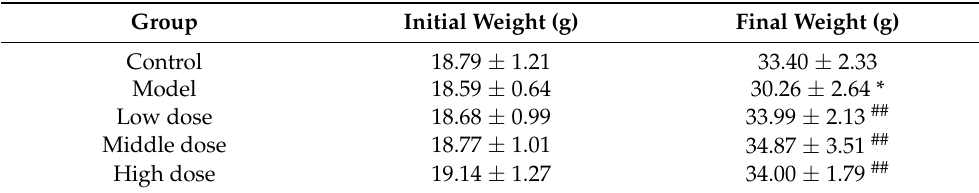
Table 1. Initial weight and final weight as the mean ± SD ( n = 10).